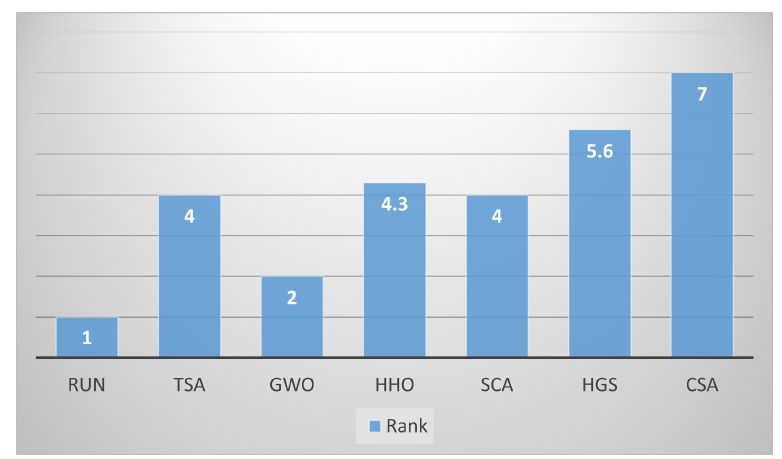
Figure 18. Friedman rank curve for